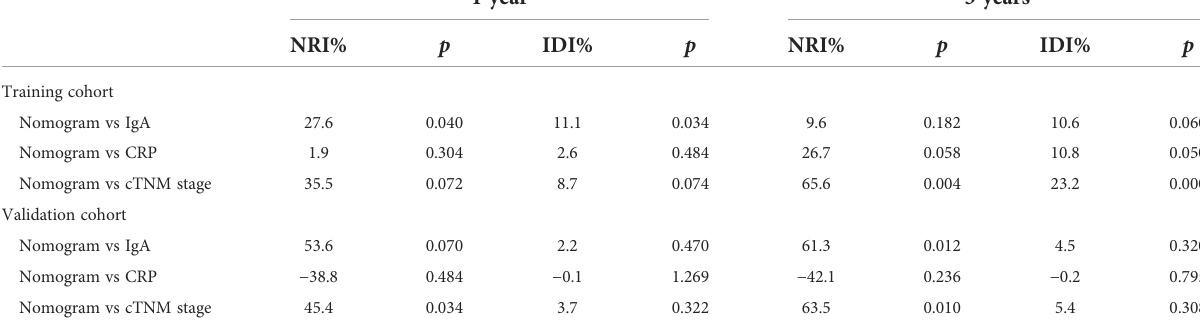
TABLE 4 Predictive improvement of the nomogram for the training and validation